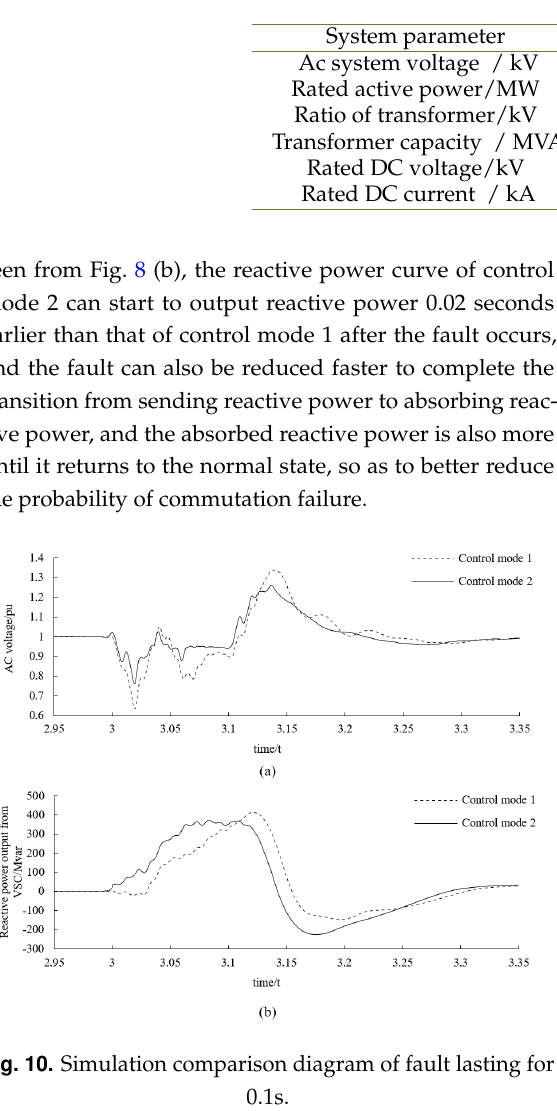
Table 2. Main parameters of VSC system.